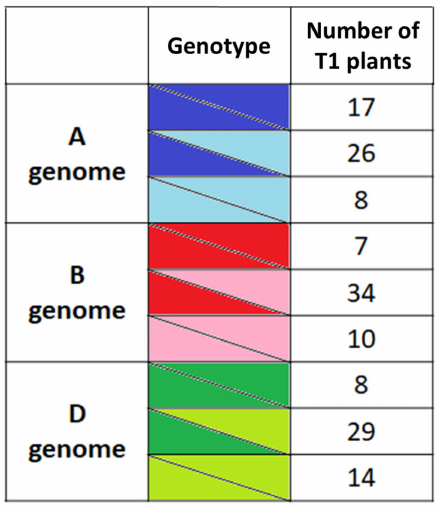
Figure 2. CRISPR/Cas-induced tabak1-2 mutant alleles were inherited by the next generation. The table shows allele distribution among T1 progeny of the T0 plant